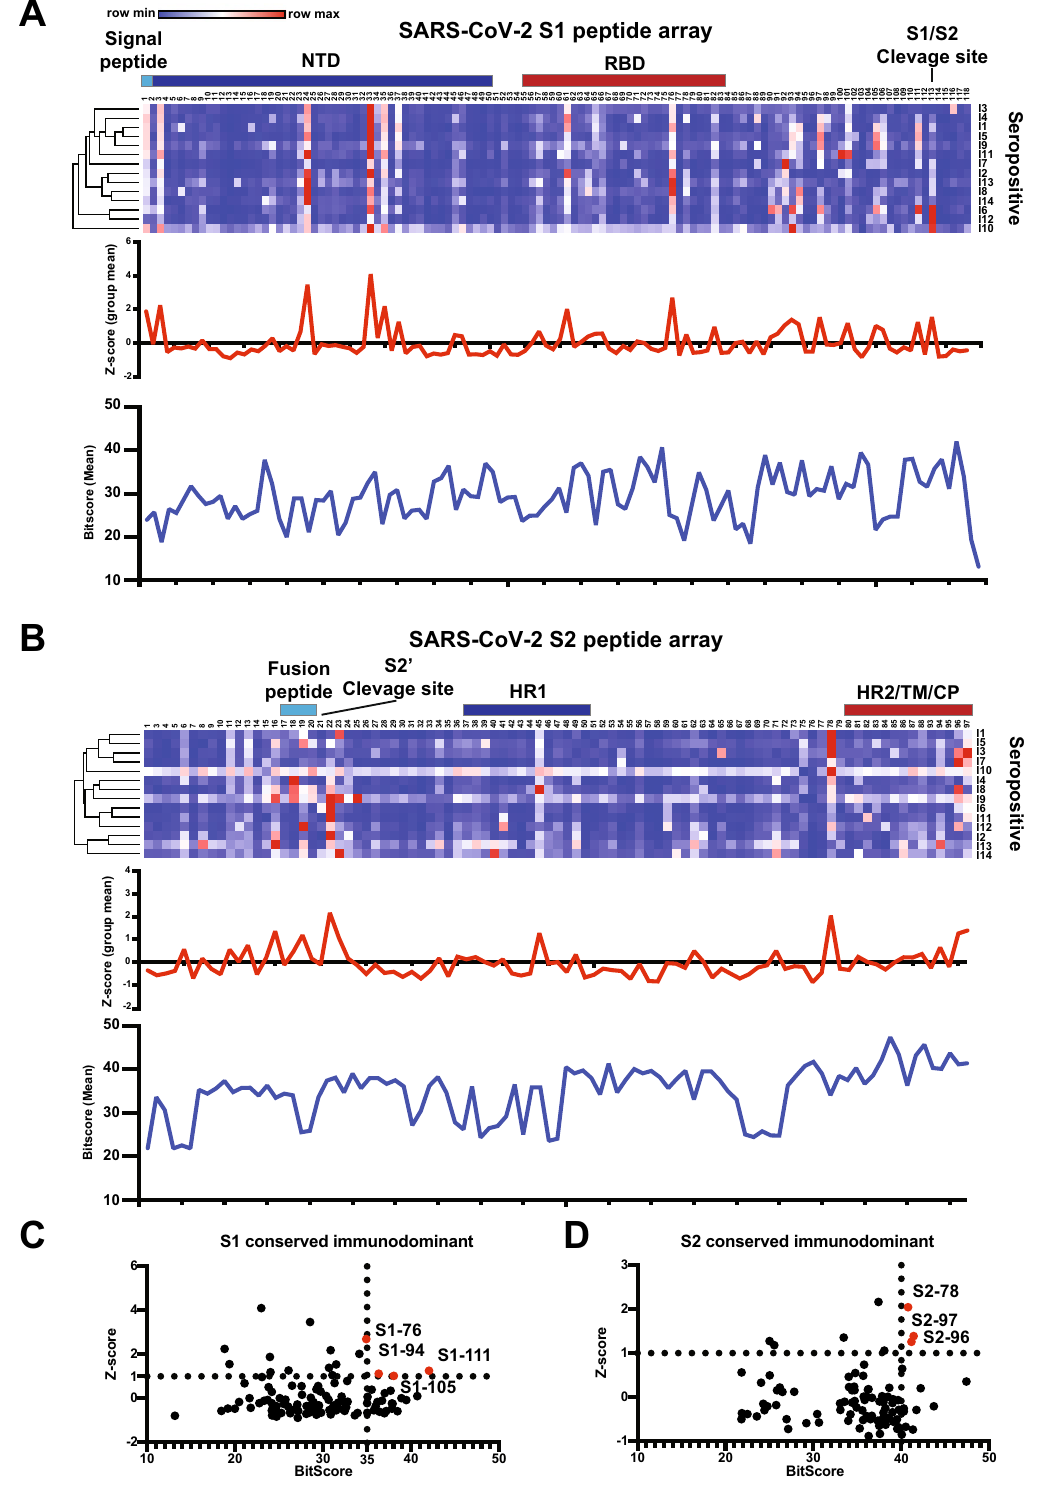
Figure 4. SARS-CoV-2 peptide array identified conserved immunodominant regions. ( A , B ) S1 ( A ) and S2 ( B ) subunits; 12-mer overlapping peptides). Seropositive (top) represents 14 individuals previously infected with SARS-CoV-2. Each peptide was printed in triplicate, and the Log2 of the mean fluorescent intensity (F635) for each peptide was graphed. The row color corresponds to the minimum and maximum intensity for all peptides for each individual. Known regions of the spike protein are annotated above the heatmaps. Line graphs display the mean group Z-score and mean Bitscore for each peptide. ( C , D ) Scatter plot of mean group Z-score versus mean Bitscore to identify putative immunodominant peptides for S1 ( C ) and S2 ( D ) subunits. NTD, N-terminal domain; RBD, receptor-binding domain; HR1, heptad repeat 1; HR2; heptad repeat 2; TM, transmembrane domain; CP, cytoplasmic